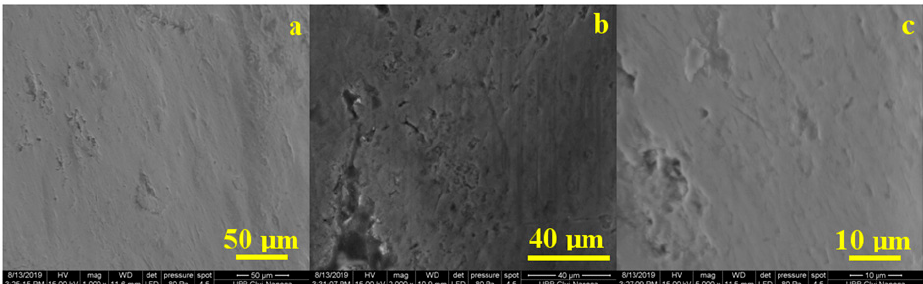
Figure 9. SEM appearance of bleached enamel with Opalescence gel: ( a ) small magnification, ( b ) medium magnification, and ( c ) high magnification. ( b ) medium magnification, and ( c ) high